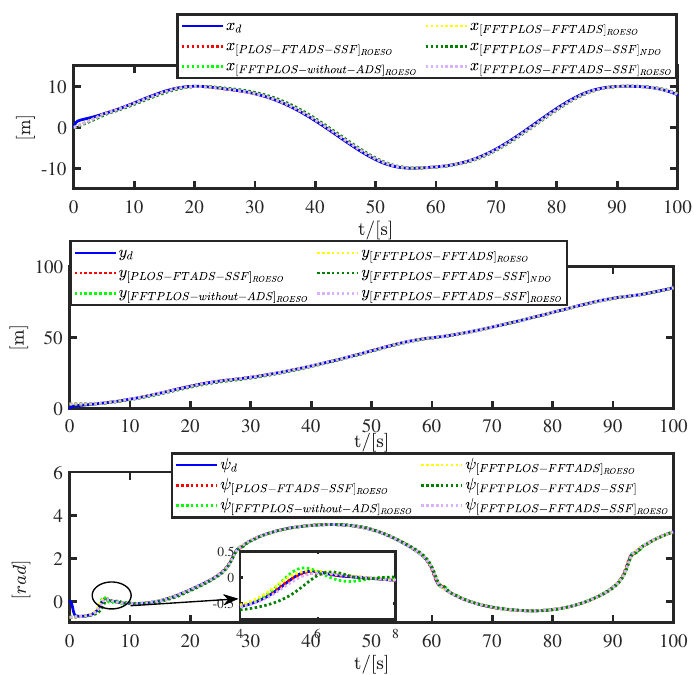
Figure 4. Comparison of along-track x , cross-track y and heading angle ψ for position